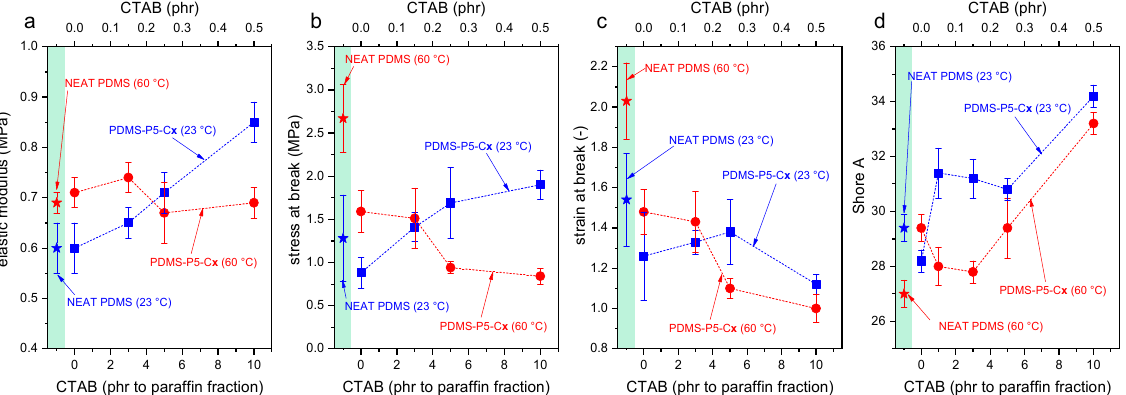
Figure 8. Main results of the tensile and Shore A hardness tests on the prepared films (samples F-PDMS-P5-Cx, x = 1–10 phr with respect to paraffin). Tensile elastic modulus ( a ), tensile stress at break ( b ), tensile strain at break ( c ), and Shore A hardness ( d ) as a function of the CTAB content and temperature. The green box contains the data of neat F-PDMS.